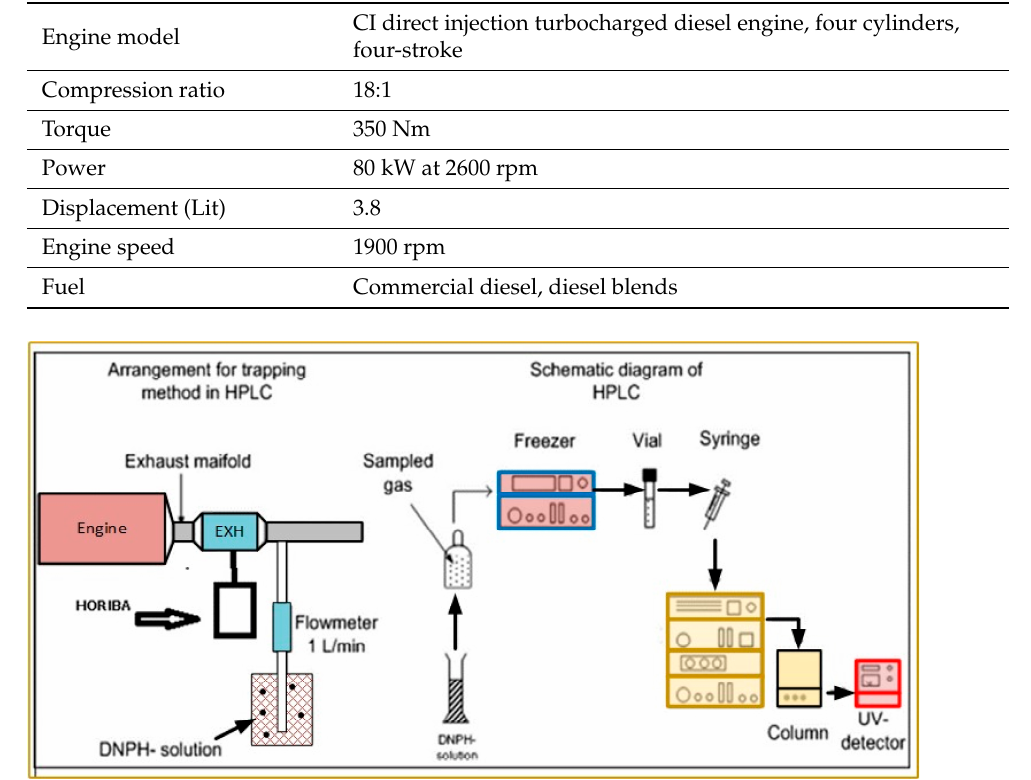
Table 1. Specifications of the engine.